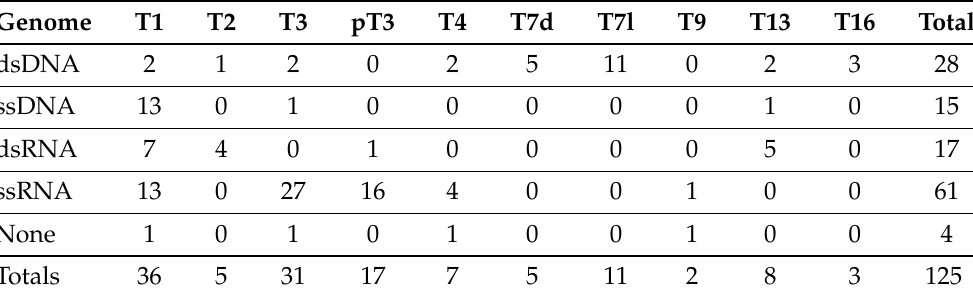
Table 1. Viral Capsid Data Set—We analyzed 135 distinct icosahedral capsids found in the VIPERdb [1]. Here, we present their genomic composition vs. T-number to illustrate the diver- sity of capsids and their genomes. We note that nearly all of the ssDNA capsids are T1 ( 87% ) , and most of the ssRNA capsids ( 70% ) are T3 or pT3. Most of the T3 capsids are composed only of ssRNA ( 87% ) . There are 10 capsids not shown here—pT21(2), pT25(2), pT27, T28d, pT31, T43, pT169, and T169—which were all dsDNA genomes. It is also clear that there is a connection between a larger T-number and dsDNA, as T7, T16 and larger capsids were found to only contain dsDNA. This is likely due to the inherent stiffness of the dsDNA molecule requiring a larger capsid to contain it. In summary, knowing the T-number only provides limited information on the genome, as does only knowing the genome provide little information on the T-number. We did not find any T12 or T19 capsids as might be expect based on [25], though pT27 and T169 were